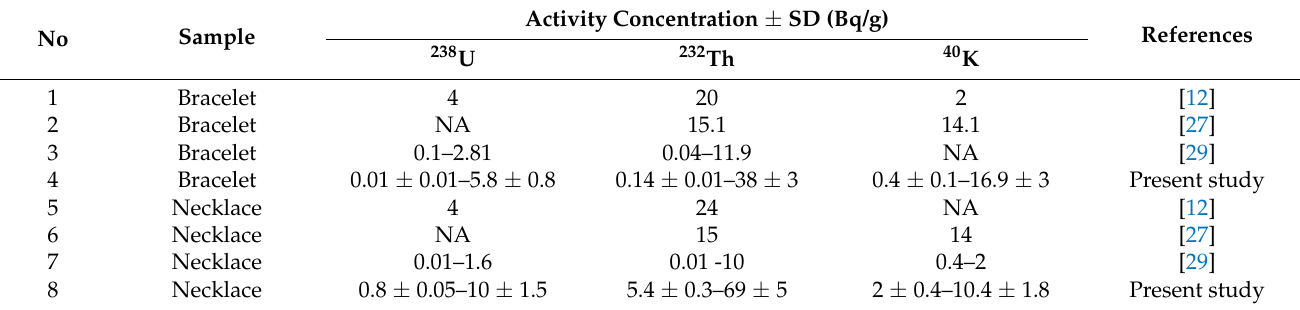
Figure 3. Overall distribution of activity concentration for 238 U, 232 Th, and 40 K in bracelet and necklace samples. Table 6. Activity of radionuclides 238 U, 232 Th, and 40 K in bracelets and necklaces. Literature data and data from this